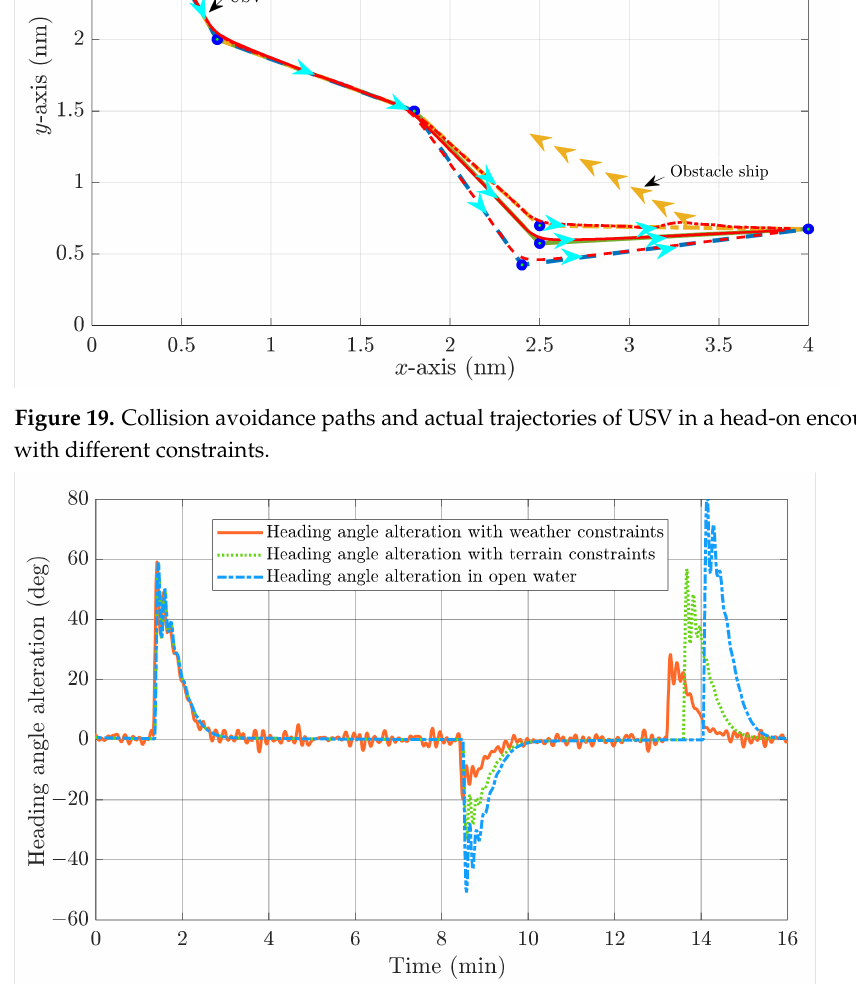
Figure 20. Heading angle alterations with different constraints in head-on encounter